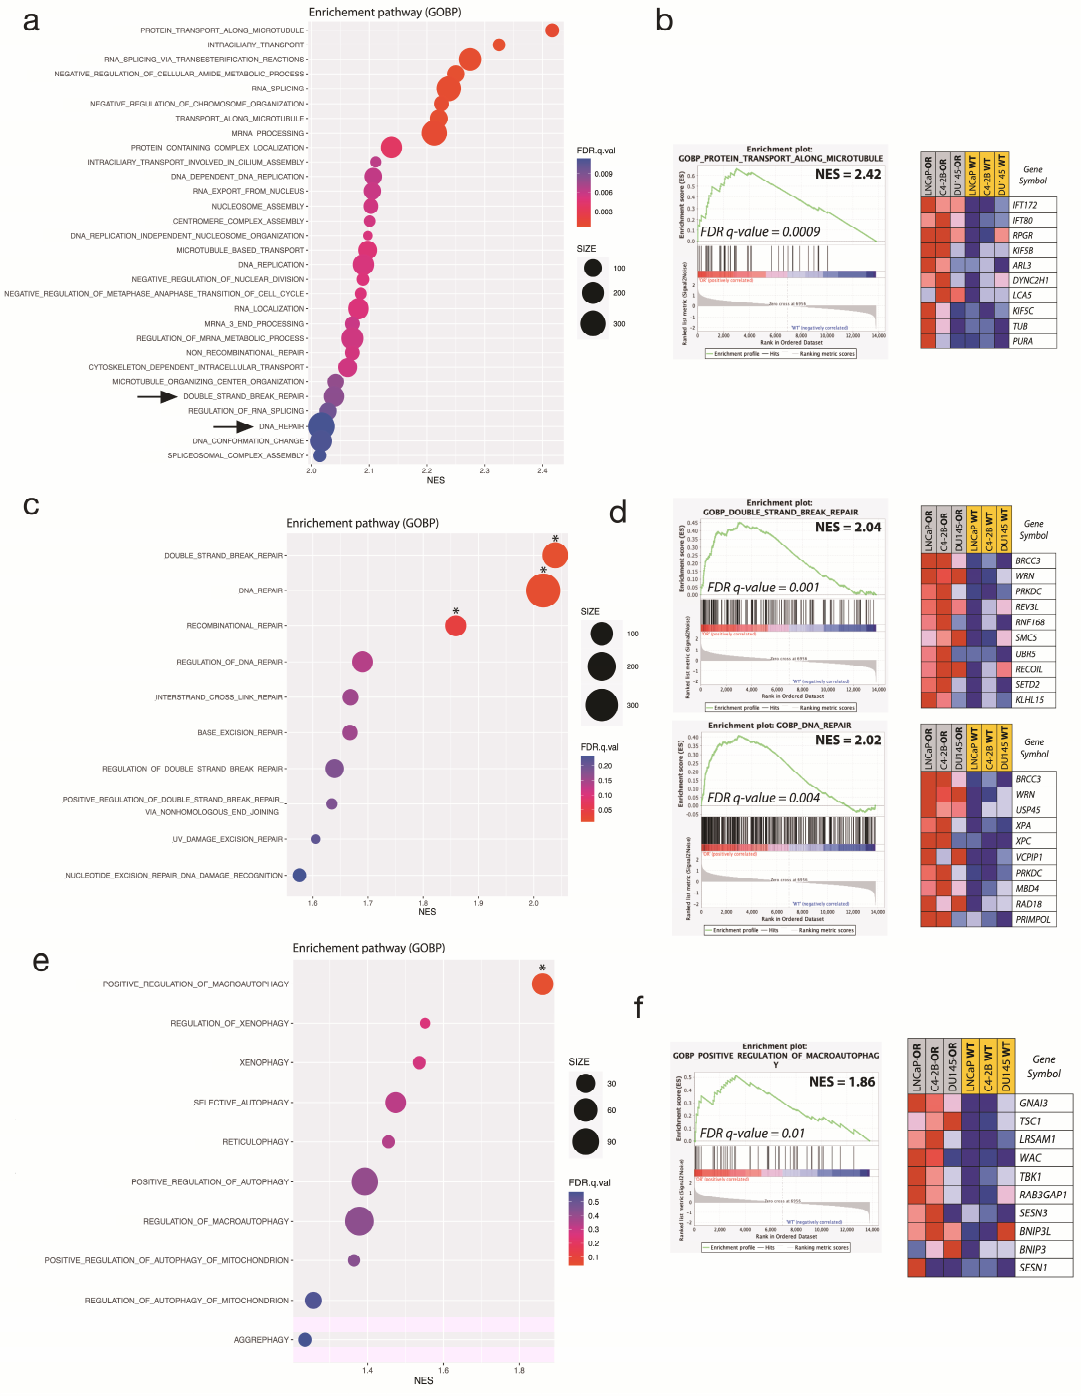
Figure 2. Enrichment pathways in PC-OR cell lines. ( a ) Bubble chart regrouping the 30 most signifi- cantly enriched pathways determined by GSEA analysis. ( b ) Enrichment plot and top 10 enriched genes in the “protein transport along microtubules”. ( c ) Bubble chart derived from the initial analysis ( a ) and regrouping the top 10 enrichment pathways linked to DNA repair mechanisms. ( d ) Enrich- ment plot and top 10 enriched genes of “double strand break repair” and “DNA repair” pathways. ( e ) Bubble chart derived from the initial analysis in ( a ) and regrouping the top 10 enrichment path- ways linked to autophagy mechanisms. ( f ) Enrichment plot and top 10 enriched genes of “positive regulation of macroautophagy” pathway. * p <